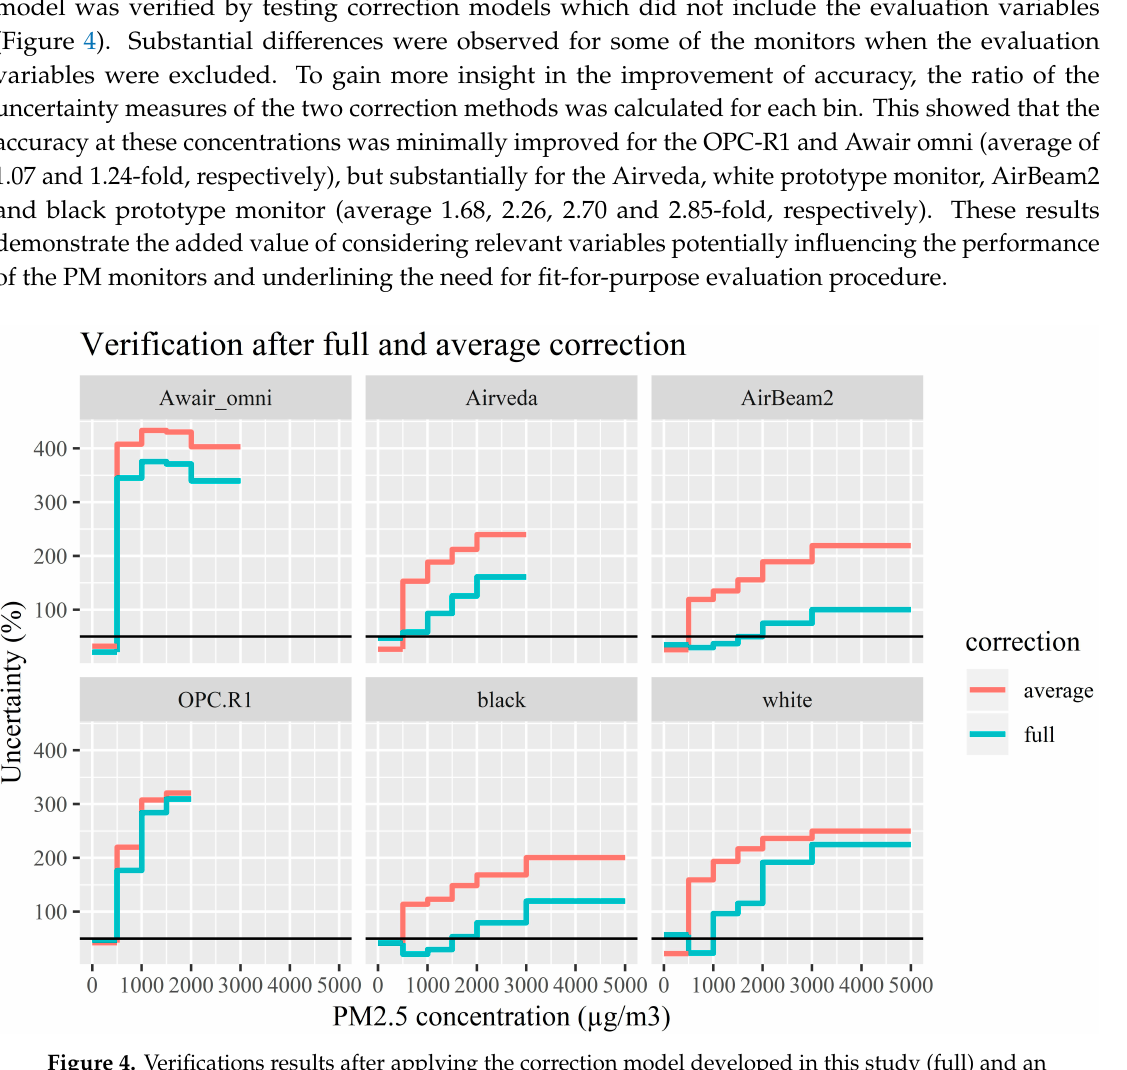
Figure 4. Verifications results after applying the correction model developed in this study (full) and an average correction. Uncertainty measures for each monitor over the concentration bins, where a low uncertainty represents a more accurate monitor. The horizontal black line indicates the target accuracy, set at